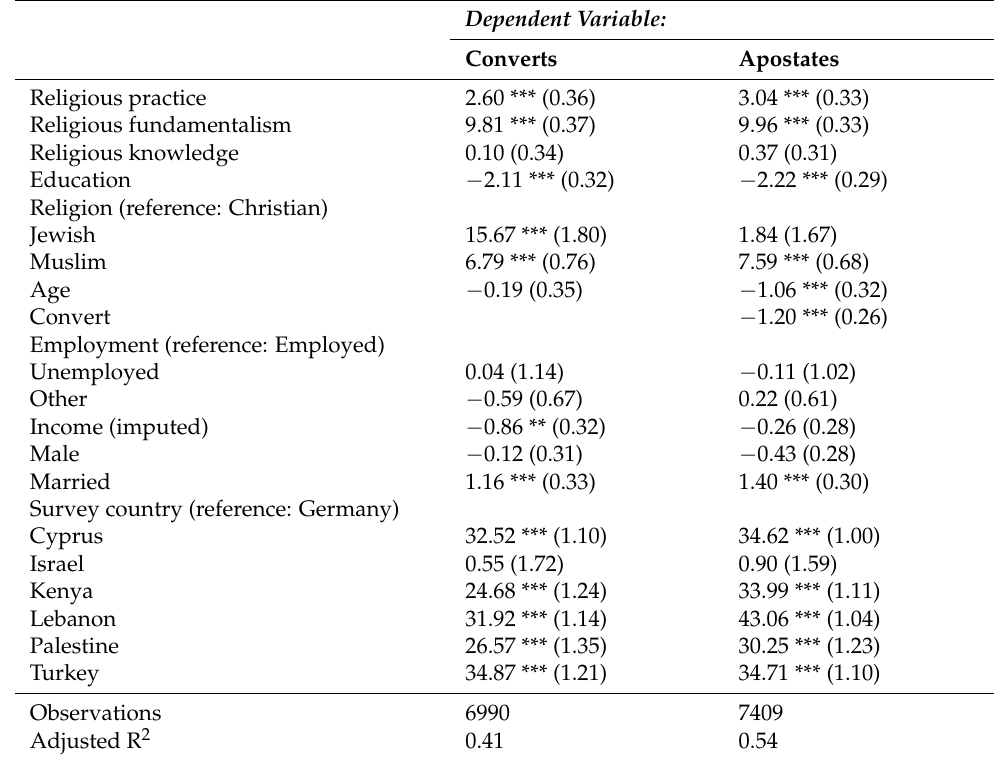
Table 2. OLS regression results of unfavorable attitudes toward individuals who leave their